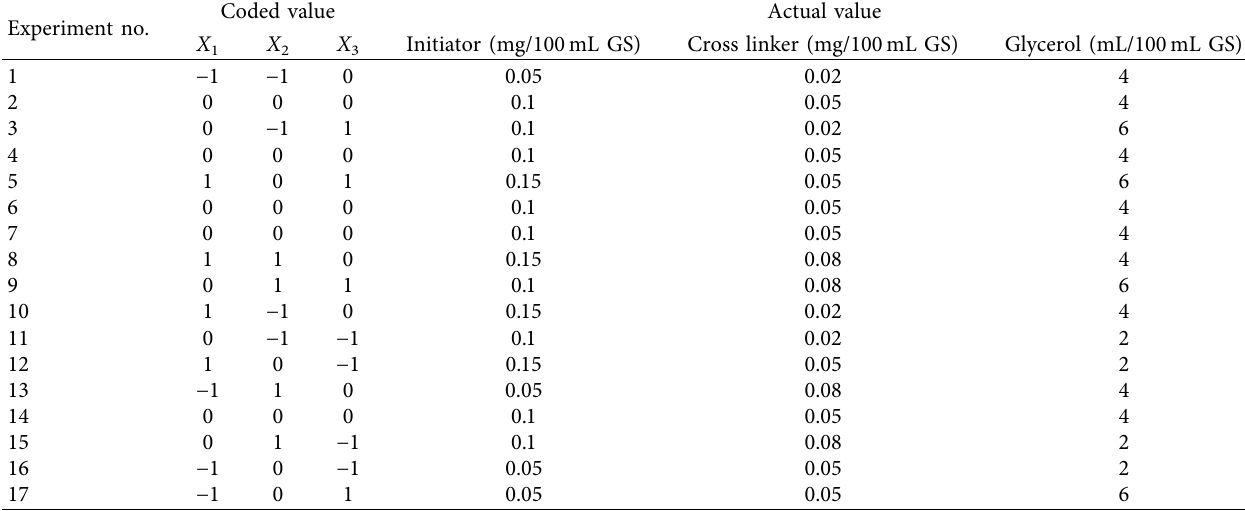
Table 2: Box–Behnken three variables experimental design for development of hydrogel-based packaging film. Experiment